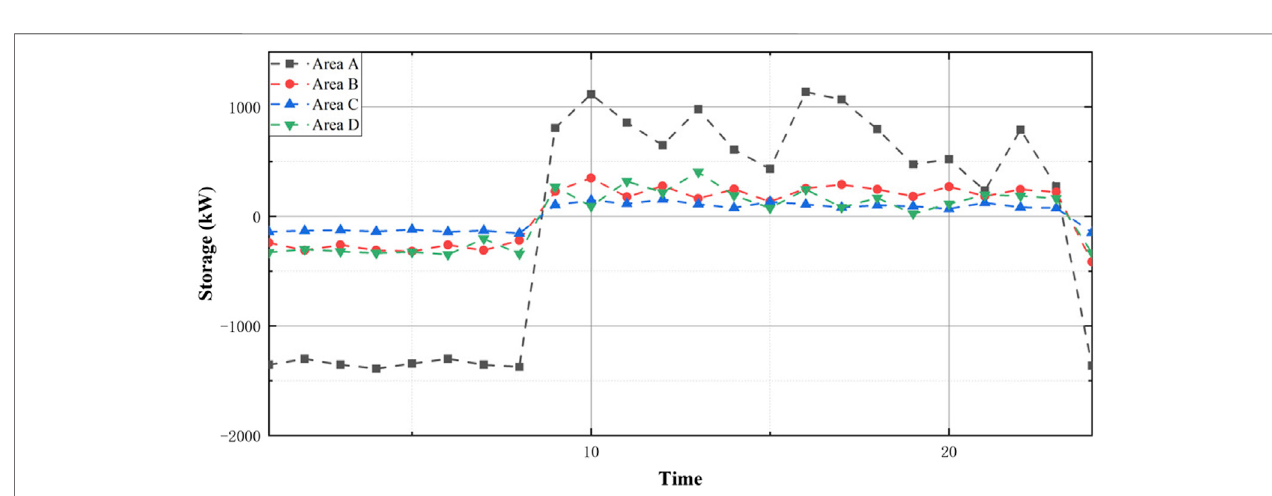
FIGURE 8 | The optimal storage strategy of active storage